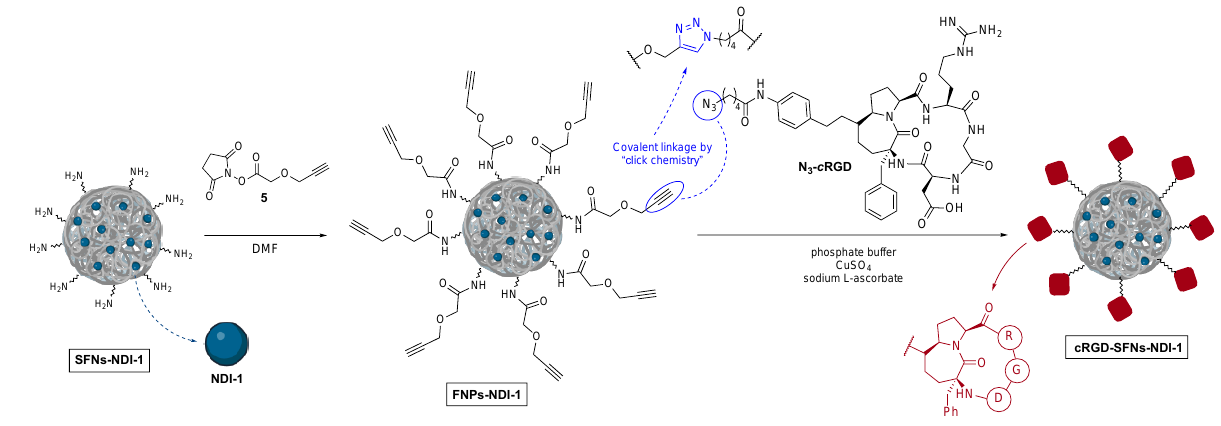
Scheme 2. Preparation of alkyne-modified silk fibroin nanoparticles and their functionalization with azide- c RGDs through click chemistry.